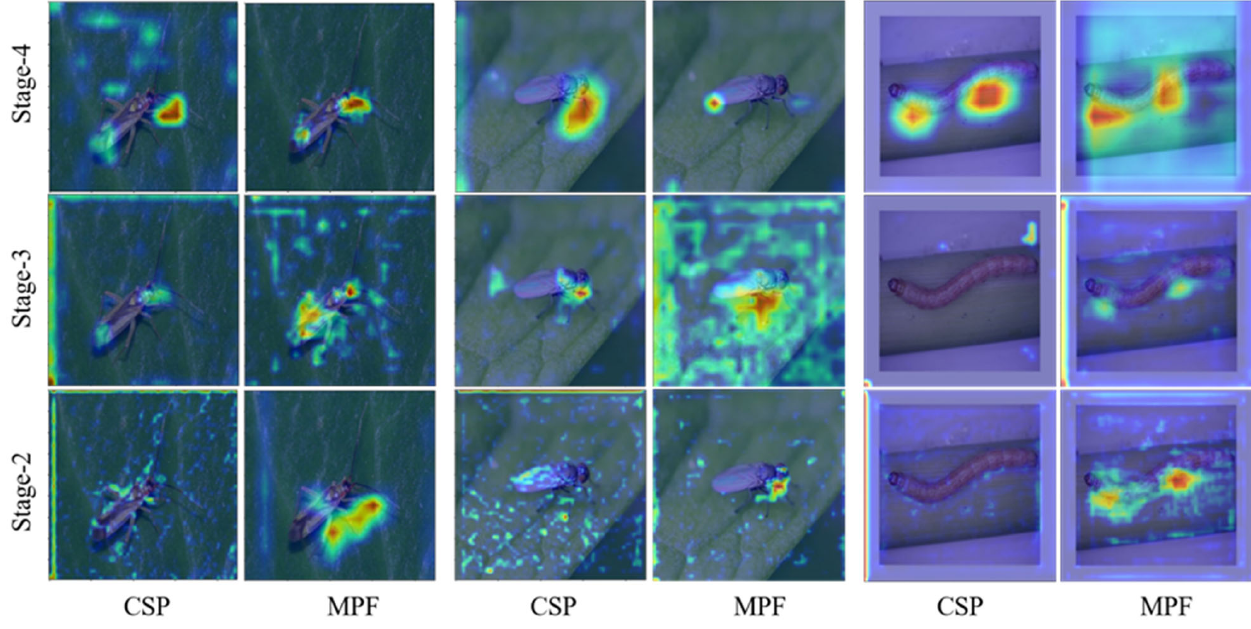
Figure 9. Class activation visualizations of baseline (CSP) and class activation visualizations of the MPF module for different stages.